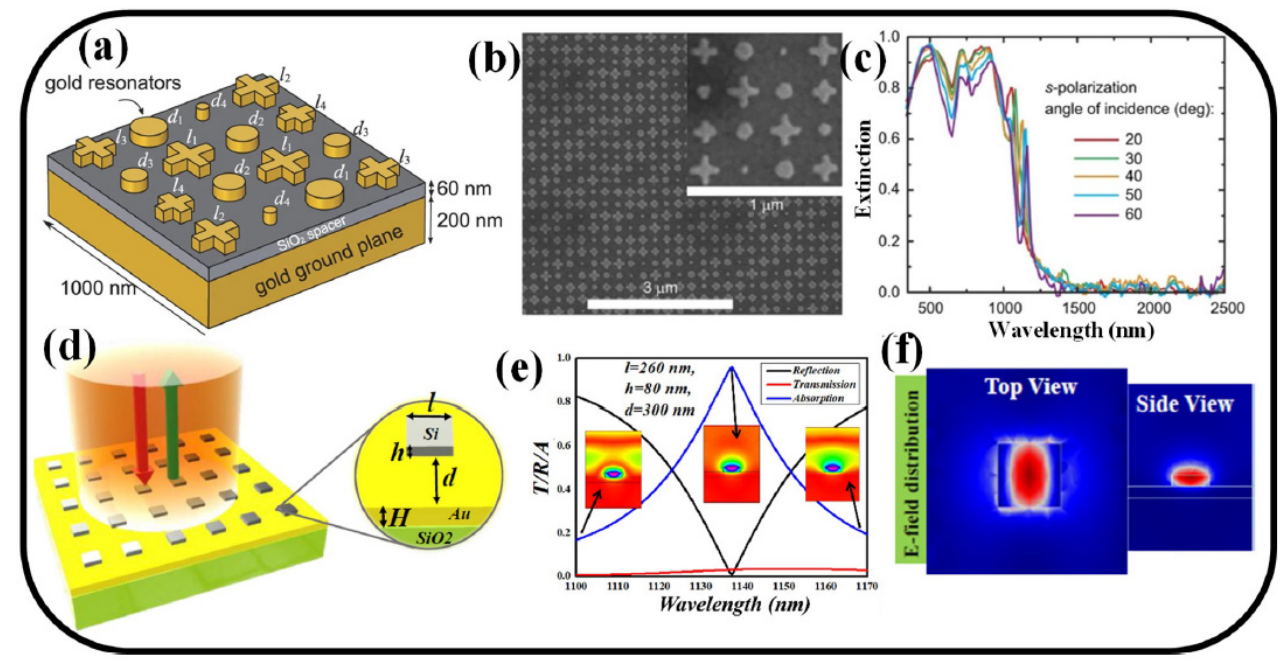
Figure 4. ( a ) Schematic representation of a broadband MS solar absorber [58], ( b ) SEM image of the fabricated device [58], ( c ) Experimentally measured extinction graph versus wavelength [58], ( d ) schematic of a hybrid narrowband perfect absorber [57], ( e ) Transmission/reflection/Absorption spectrum [57], and ( f ) E-field distribution at the resonance wavelength [57].